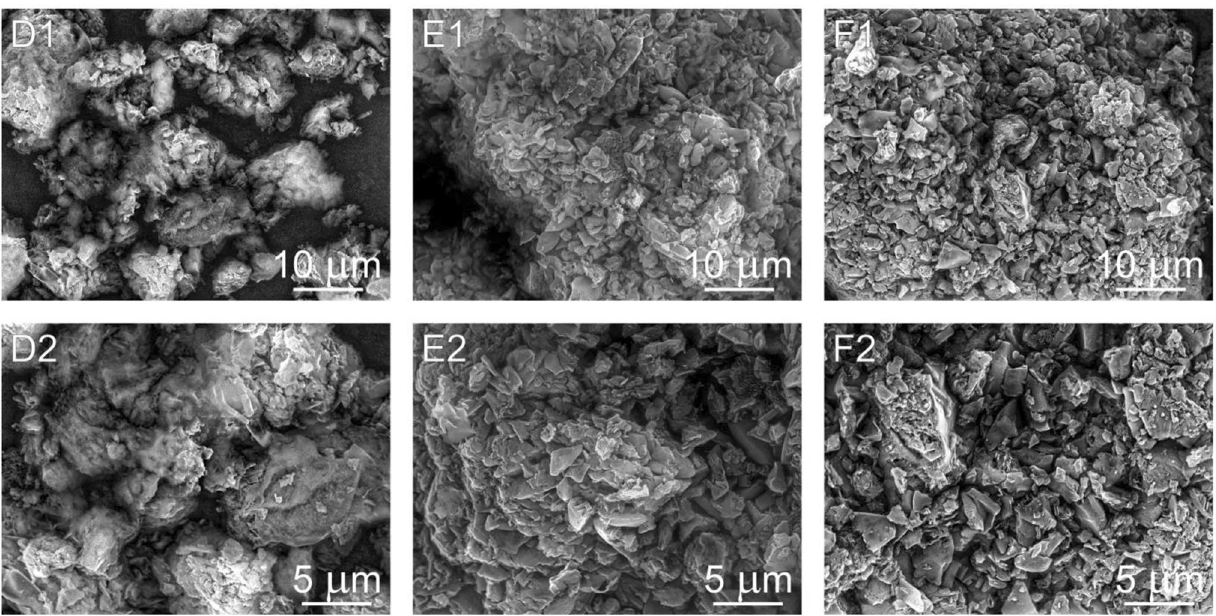
Figure 10. Micrographs (SEM:SE + BSE) of CN-GD 0.5 ( D1,D2 ), CN-GD 2 ( E1,E2 ) and CN-GD 4 ( F1,F2